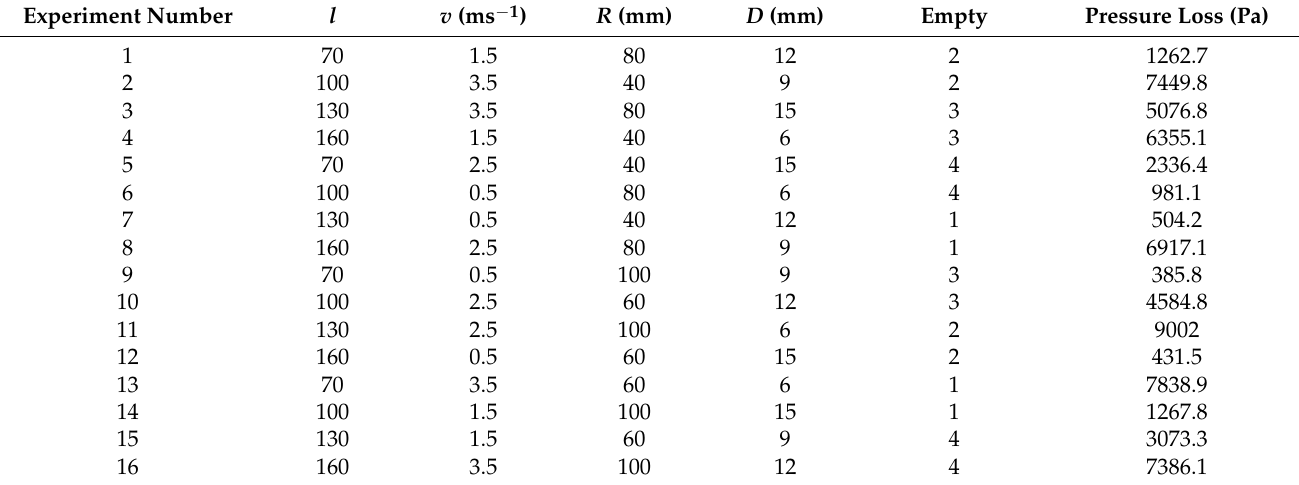
Table 3. Simulation results of orthogonal experimental design.